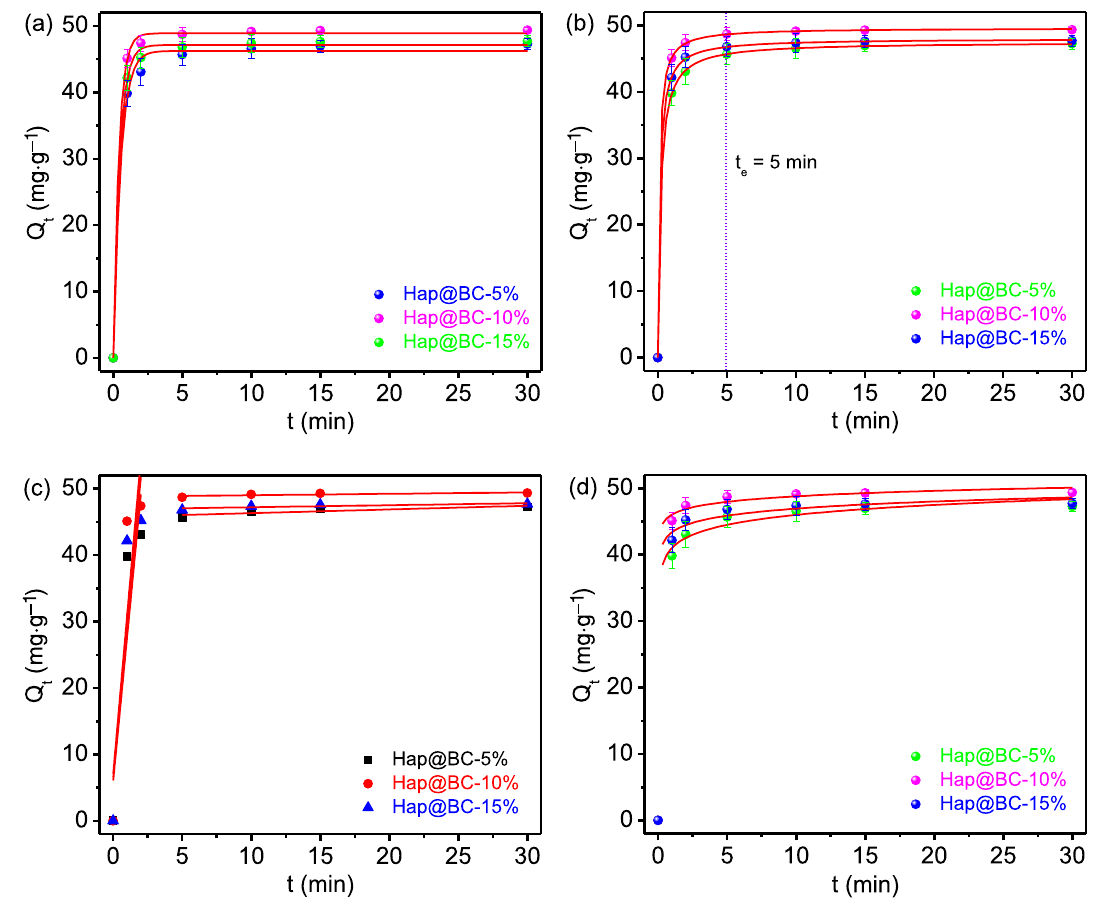
Fig. 5 Adsorption kinetic models: a Nonlinear PFO model, b Nonlinear PSO model, c Intraparticle diffusion model and d Elovich model (C i = 5 mg/L, pH = 3, m/V = 0.1 g/L and T = 298 K)